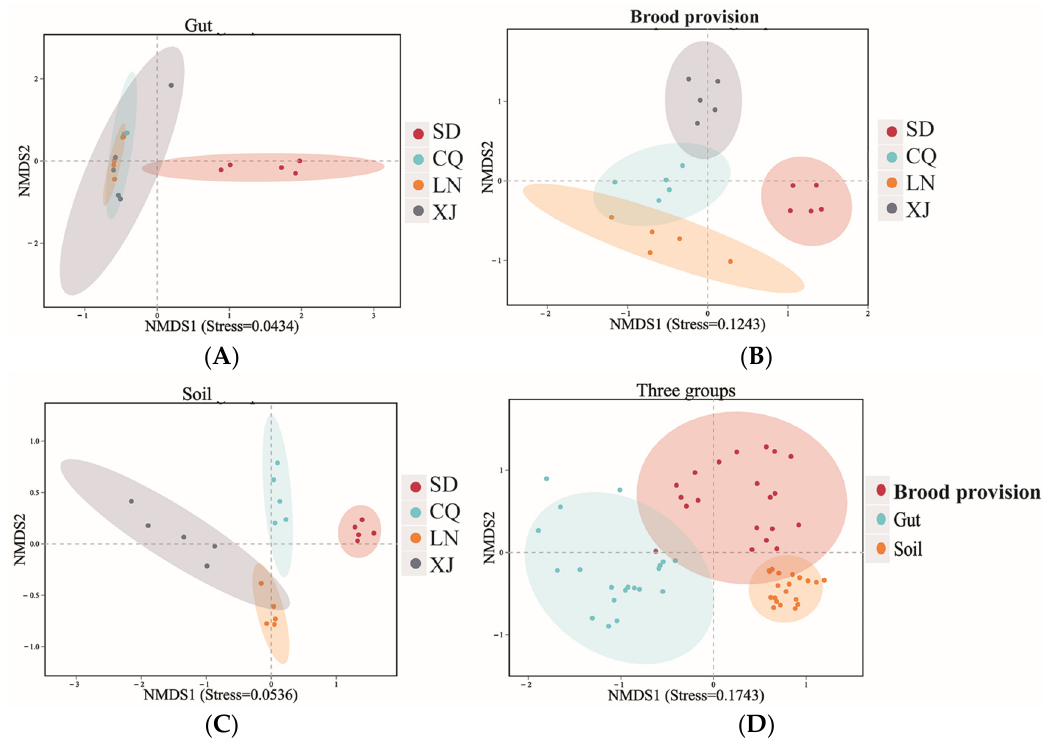
Figure 5. Nonmetric multidimensional scaling (NMDS) analysis of gut ( A ); brood provision ( B ); nest soil ( C ); and the above three groups in total ( D ).